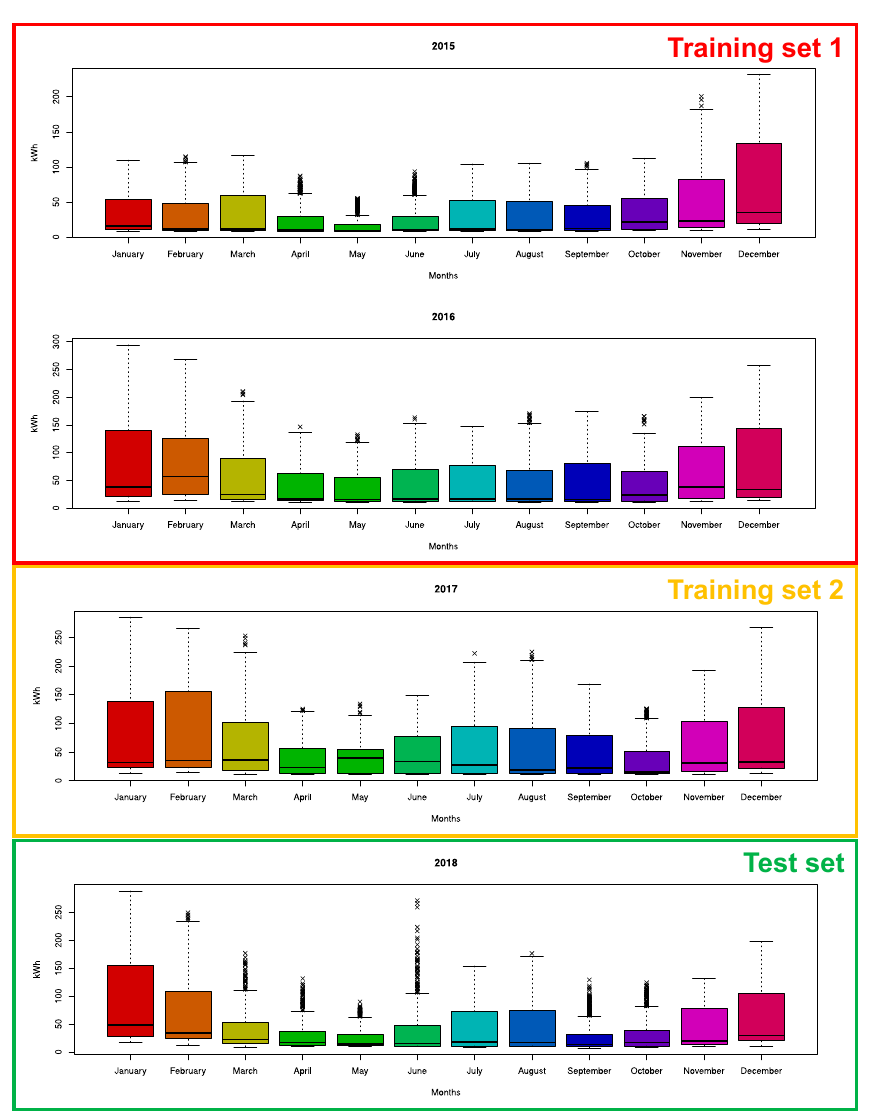
Figure 3. Box plots by the monthly electric load for separation of training and test sets.